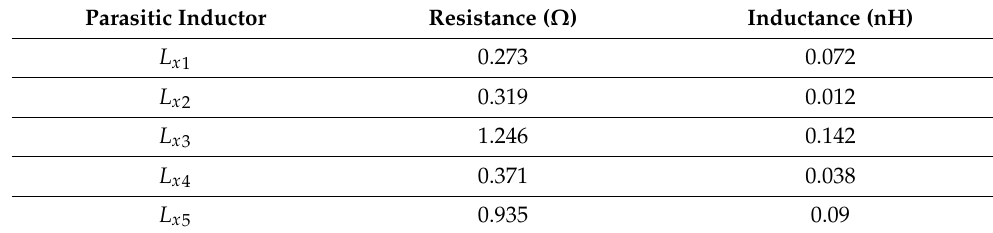
Figure 11. Lumped balun circuit with parasitic inductors. Table 3. Estimated parasitic inductors from the layout at 10 GHz.